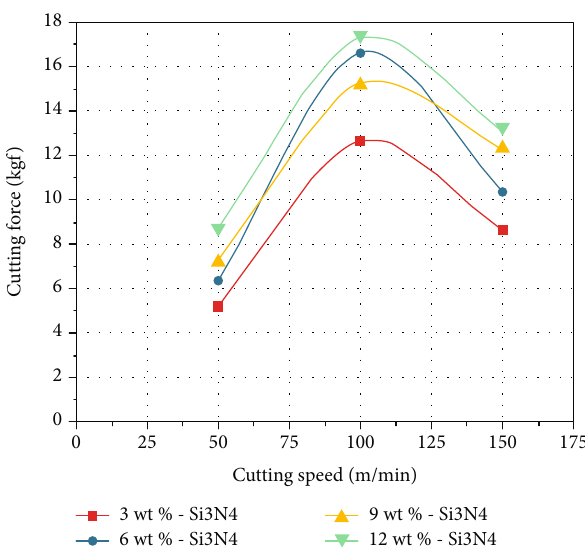
Figure 9: Cutting speed vs. cutting force (depth of cut 0.8mm).